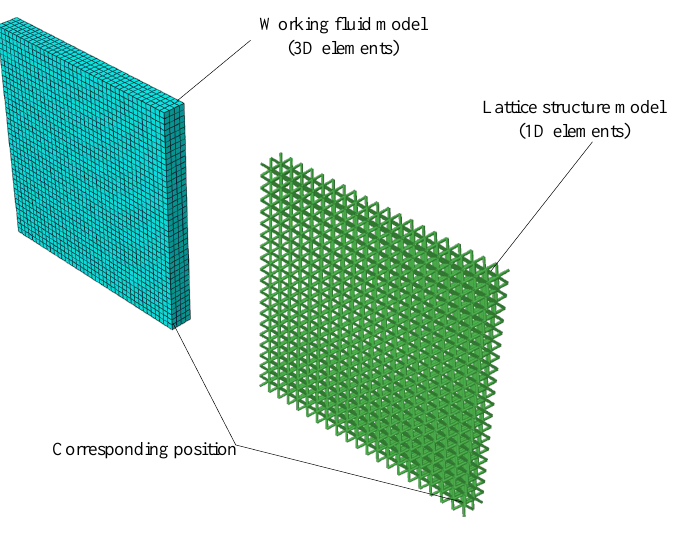
Figure 10. Finite element